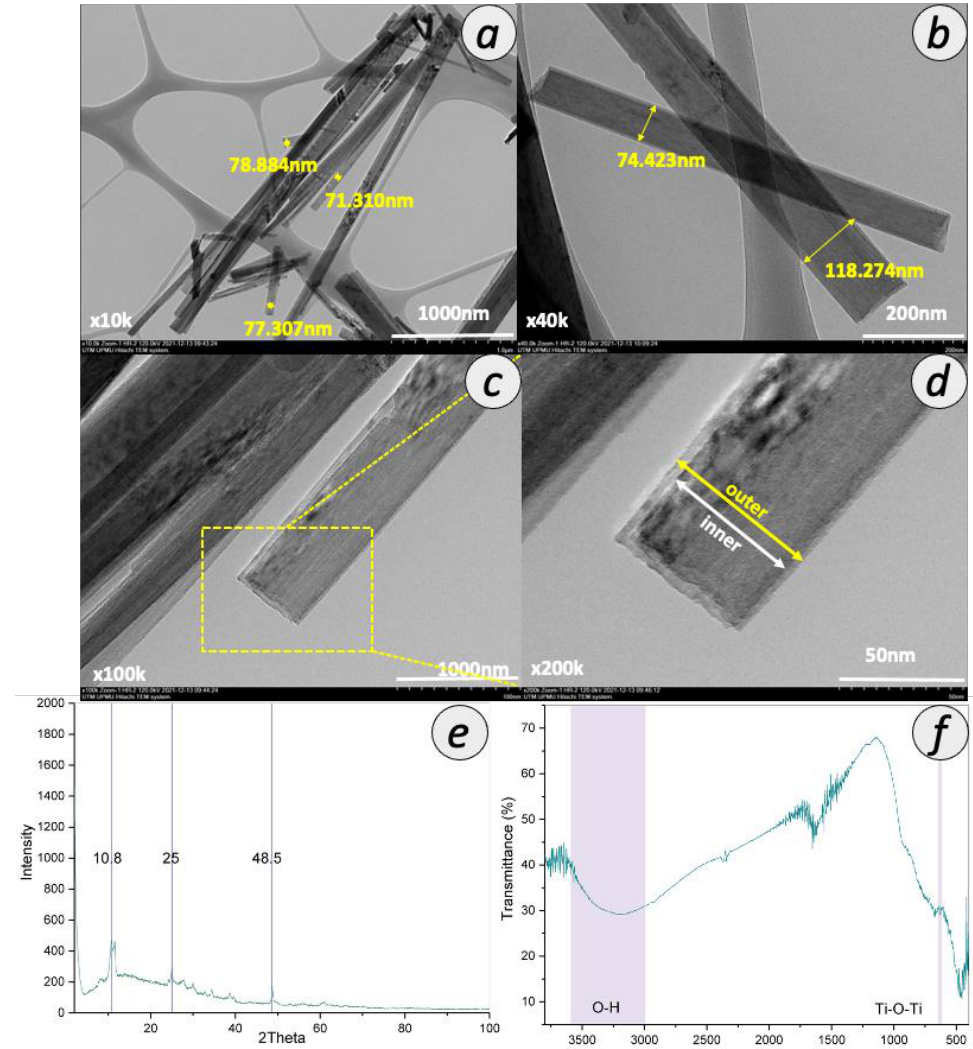
Figure 3. Properties of synthesized TNT with TEM image with magnification of ( a ) 10,000×, ( b ) 40,000×, ( c ) 100,000×, ( d ) 200,000×, ( e ) XRD spectra and ( f ) ATR-FTIR spectra.